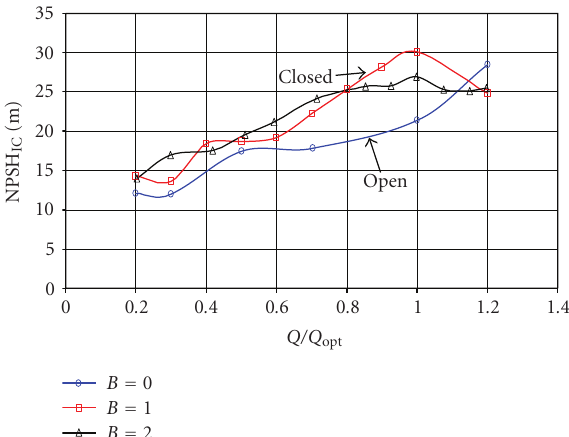
Figure 9: Head drop and vibration values ( B = 1, n = 725 rpm).